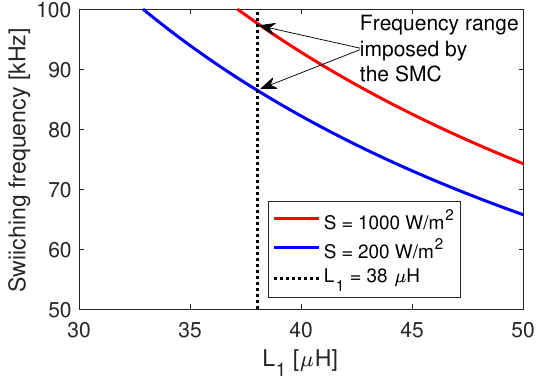
Figure 9. Design of the inductors in the CIOC